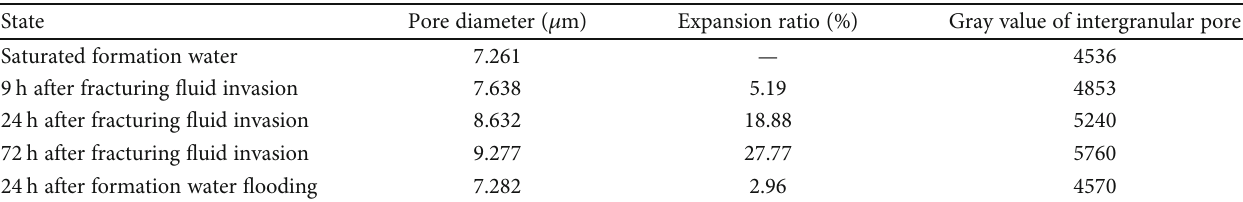
Figure 3: Characteristics of mineral size changes of typical intergranular pores at di ff erent stages (Note: (a) snapshot following saturation with formation water; (b) 9 h after fracturing fl uid invasion; (c) 24h after fracturing fl uid invasion; (d) 72 h after fracturing fl uid invasion; (e) 24h after subsequent water fl ooding). Table 3: Changes of typical intergranular pore size over